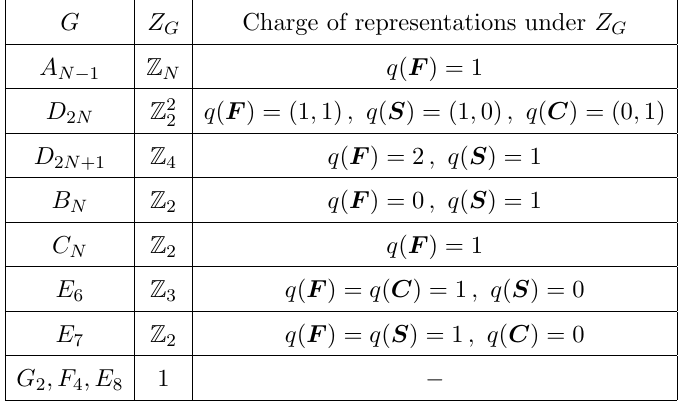
Table 1 . Lie groups G and their centers Z G , as well as the charges of some of the representations. We will always consider the simply-connected form of the gauge